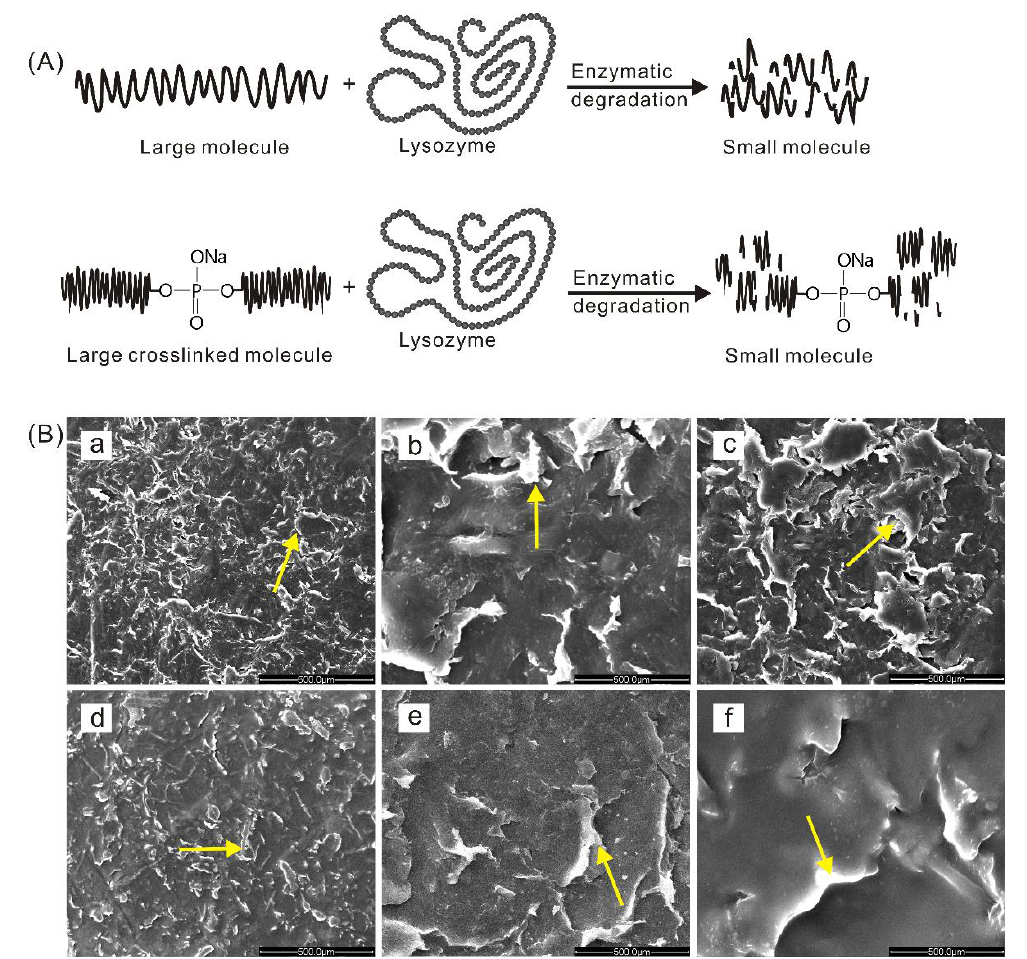
Figure 6. ( A ) The degradation of molecules under lysozyme; ( B ) SEM of films after degradation. a, CSF; b, CSMCF1; c, CSMCF2; d, CCSF; e, CCSMCF1; f, CCSMCF2.